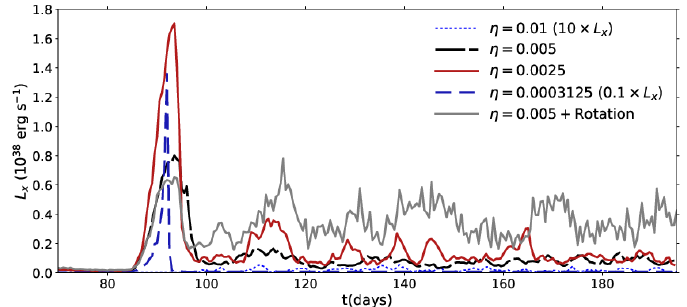
Figure 6. The total emitted X-ray from the entire simulation grid (absorption is not included). Note the different scaling for some of the runs. The initial peak is the result of interaction of the enhanced wind with the previous CWS from the fiducial run (Run 1). The average X-ray luminosity (excluding the initial peak) is given in Table 1 and Figure 7. In Run 4 that included the orbital motion, the luminosity is stronger than in Run 3, which had the same parameters without orbital motion.